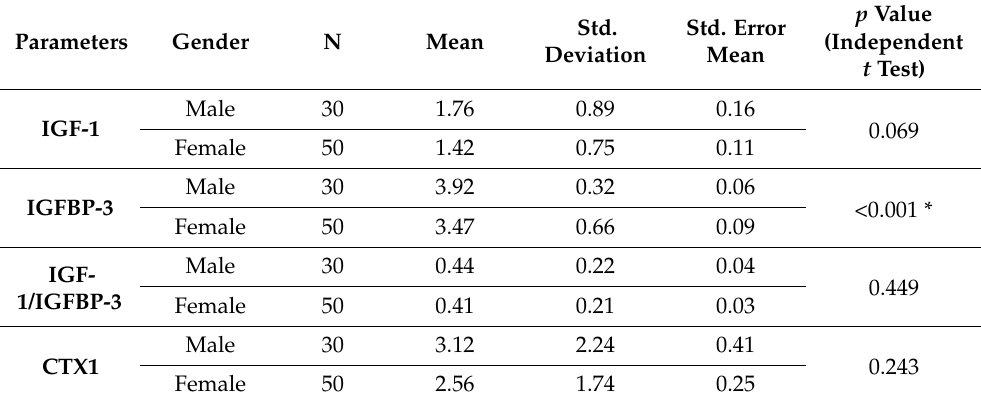
Table 3. Comparison of the biochemical parameters among genders.